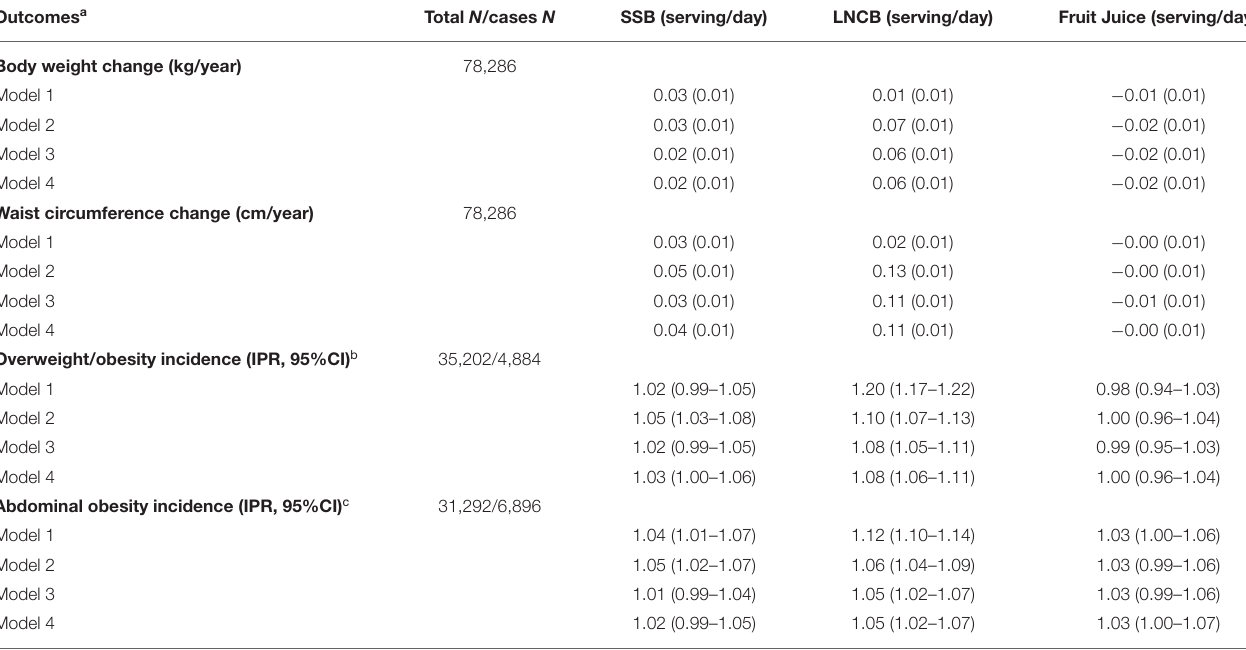
TABLE 2 | Linear associations between sugar-sweetened beverages, low/no-calorie beverages, fruit juice consumption, and weight-related outcomes in the Lifelines Cohort Study. Outcomes